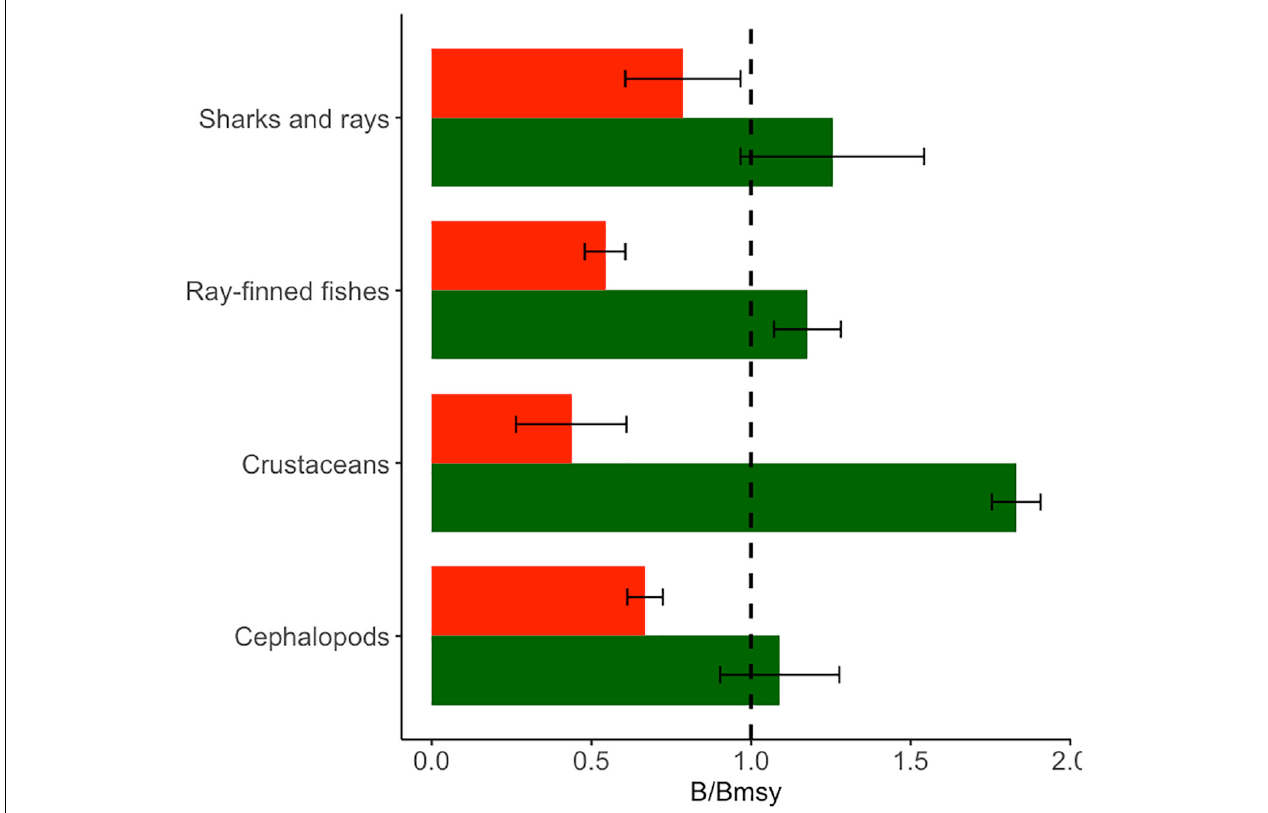
FIGURE 4 | Histogram of the mean B/B msy per taxonomic group for 116 fish and invertebrate stocks of the Aegean Sea (42 previously assessed stocks with the CMSY method and 74 stocks assessed with the AMSY method in the present study). Stocks were grouped as targeted (red bars) that include prime and alternative targets of Table 1 and non-targeted (green bars) that include by-catch and discard stocks of Table 1 . The vertical dashed line denotes the limit for healthy status (B > B msy ).